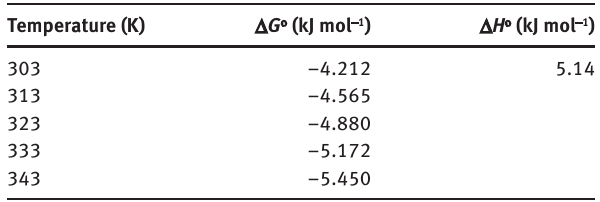
Table 4: The influence of temperature on fluoride adsorption of RHA/Al(OH) . 3